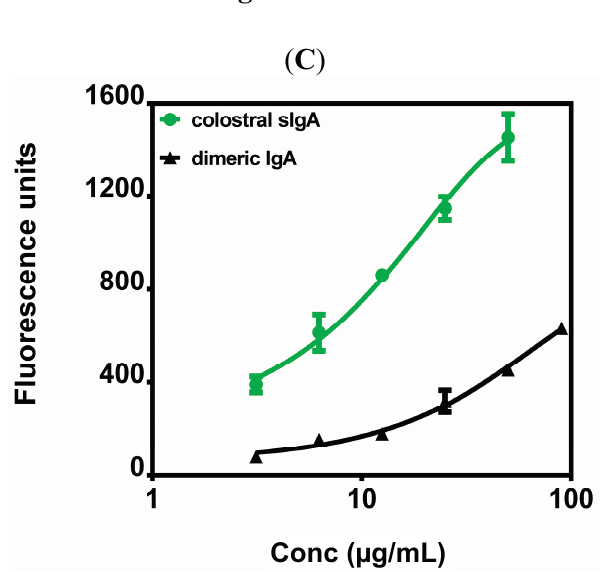
Figure 4. Polyclonal IgA neutralizes toxicity of C. difficile toxins A and B